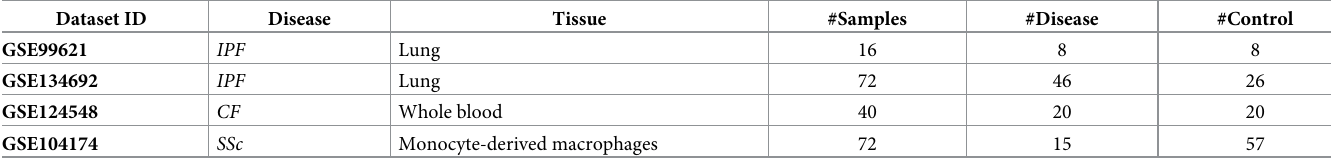
from monocyte-derived macrophages. Additionally, the number of samples (total, disease and control) that we experimented on, for each dataset entry, is shown on the table.